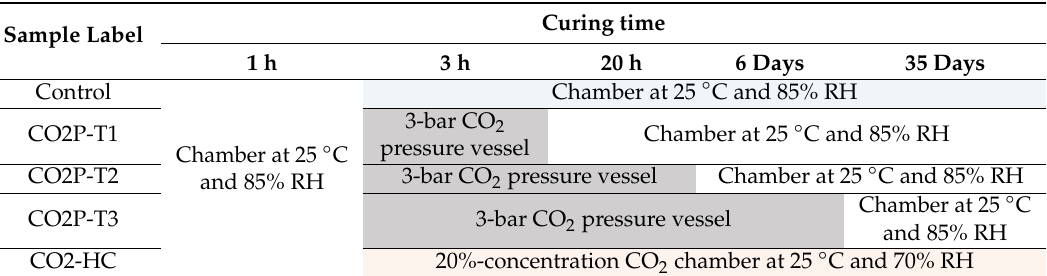
Table 3. Curing conditions of